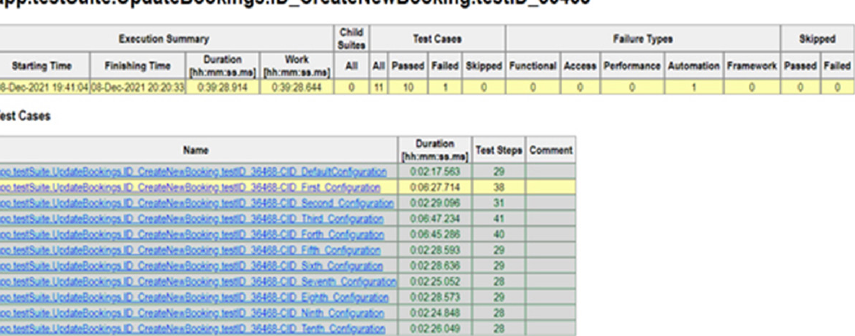
Fig. 9. Test execution